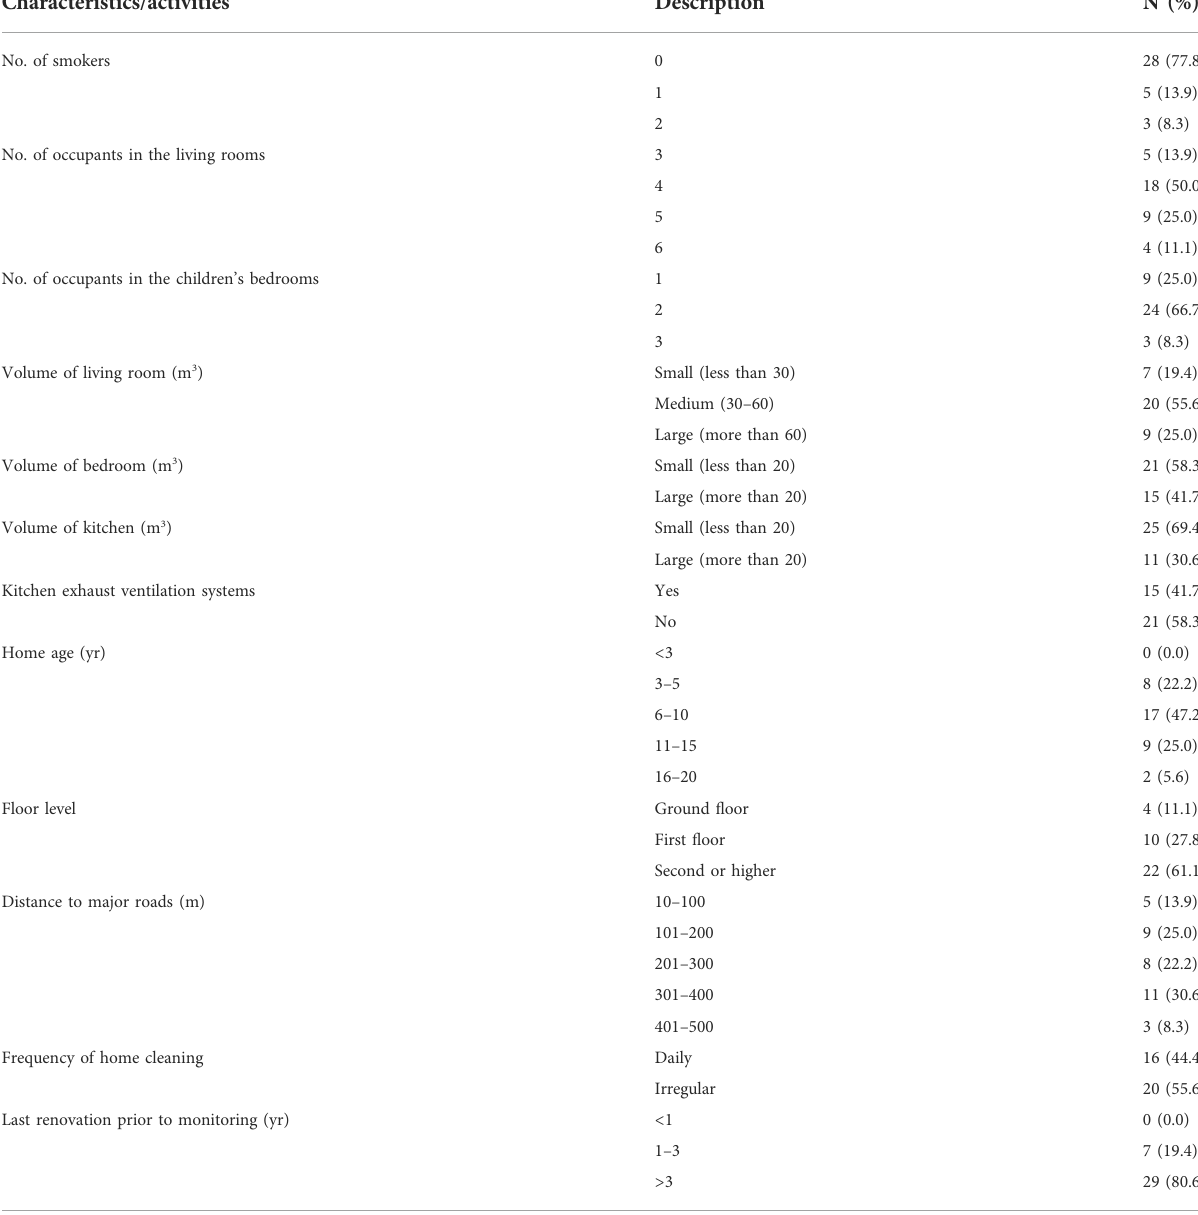
TABLE 1 Occupants ’ activities and household characteristics of the studied